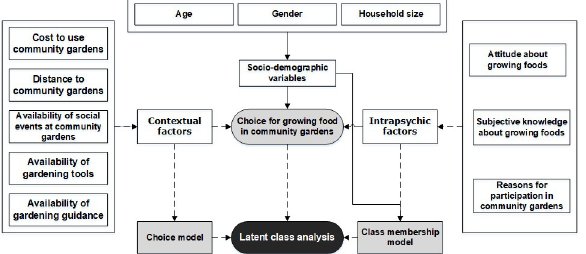
Fig 1. Conceptual framework showing the relationships between contextual and intrapsychic factors and the choice for growing foods in CGs. Dotted lines represent our contribution to the literature where there are no studies, yet, investigating these interactions using latent class